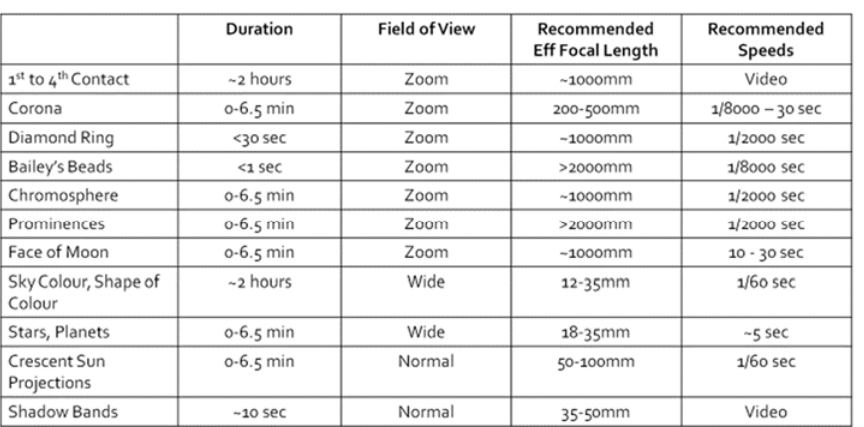
Table 2. Recommended